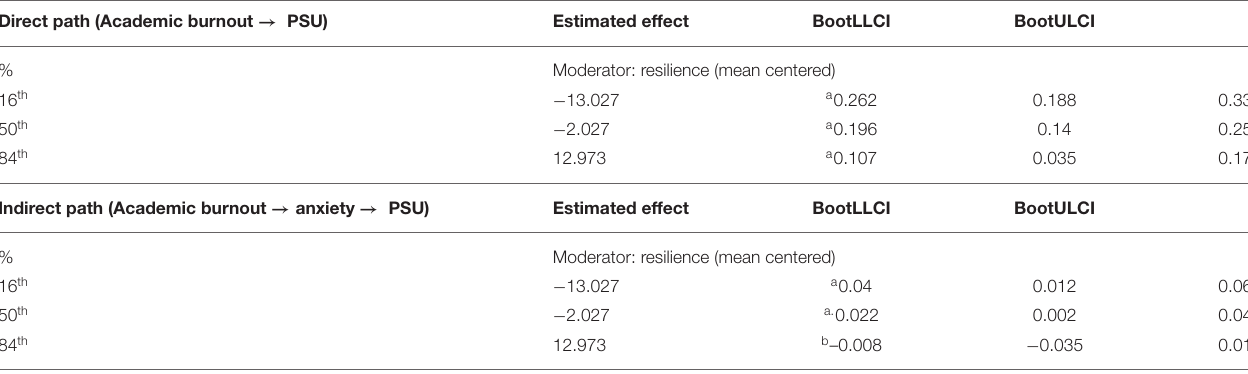
TABLE 5 | Bootstrapping the conditional direct and indirect effects and 95% confidence interval (CI) for the moderated mediation model. Direct path (Academic burnout →